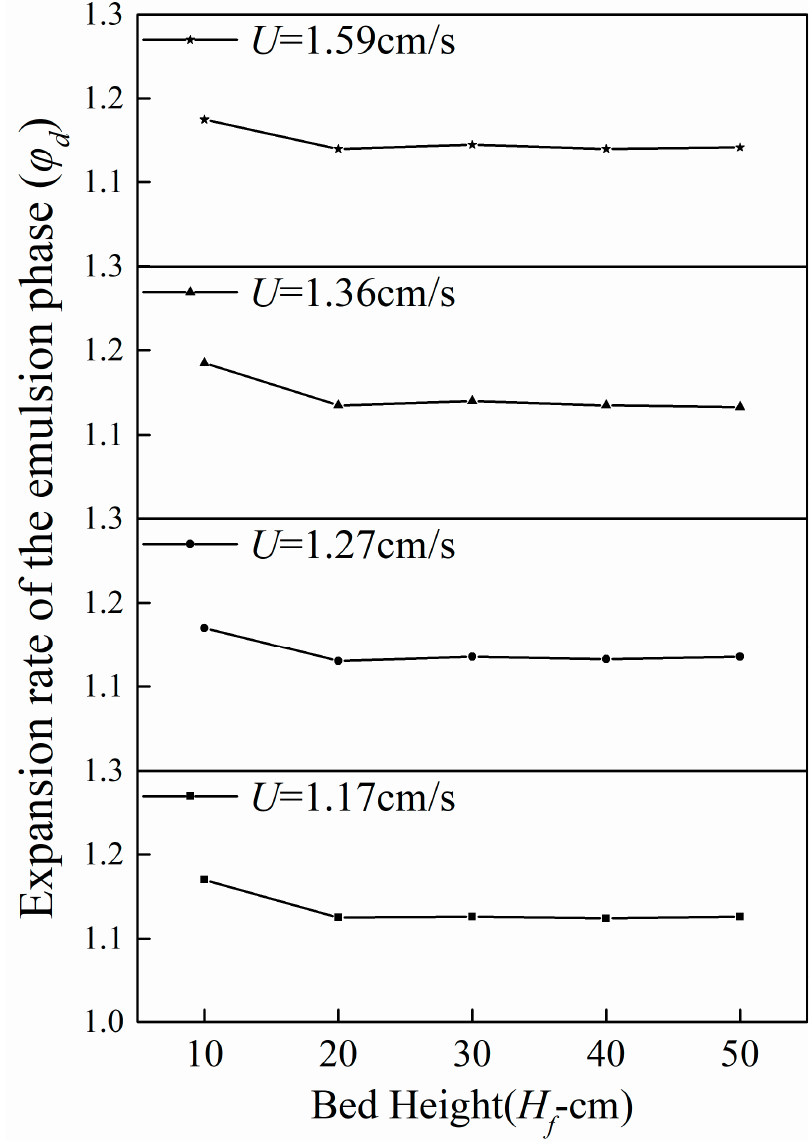
Figure 6. Effect of bed height on the expansion of the emulsion phase.